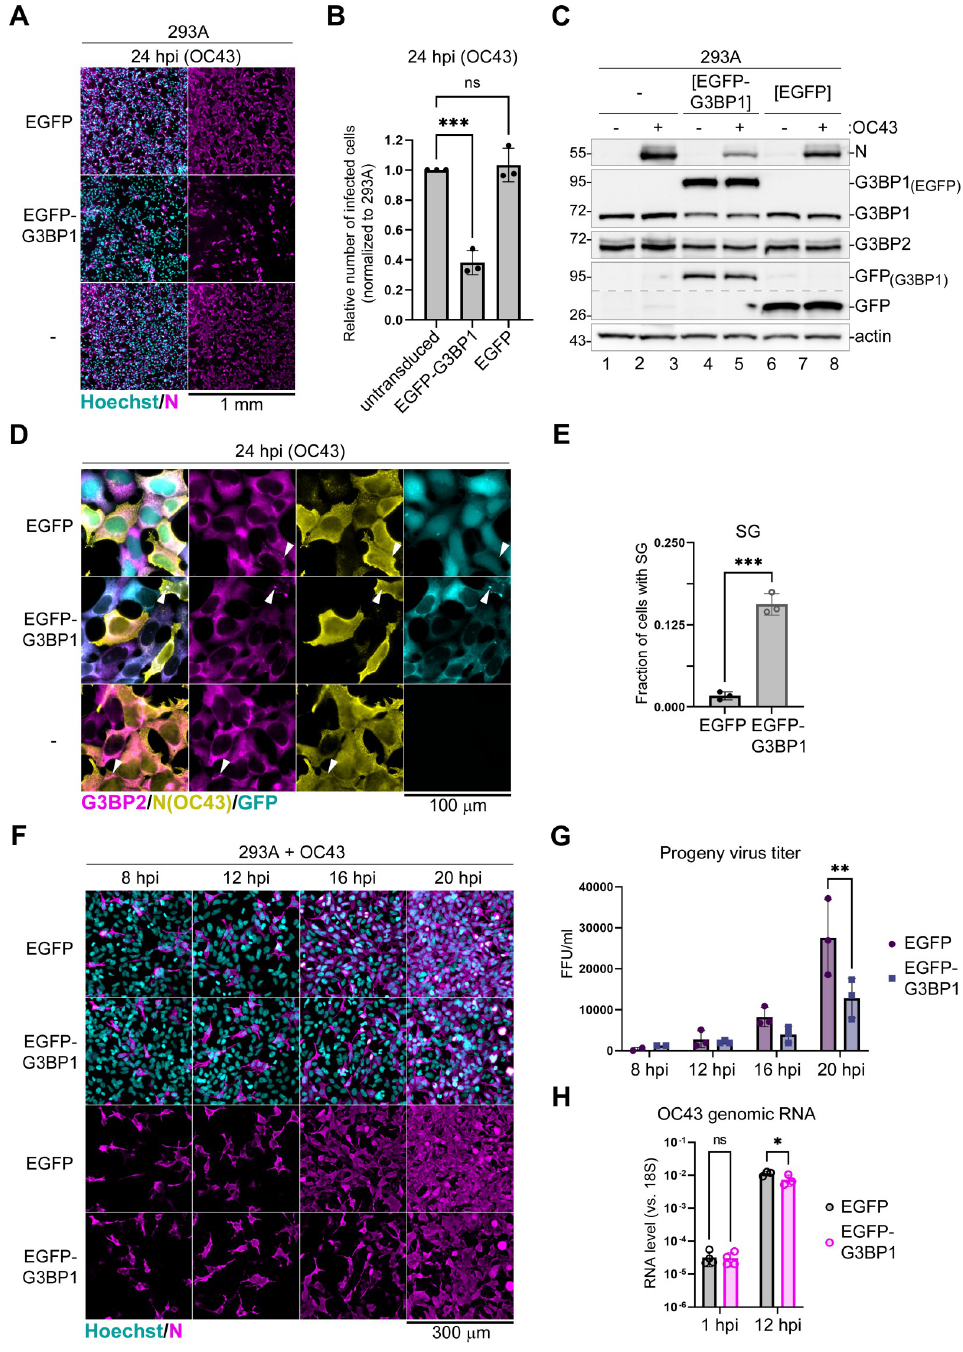
Fig 8. G3BP1 overexpression inhibits OC43 replication. (A) Immunofluorescence microscopy analysis of parental 293A cells (-), 293A[EGFP], and 293A[EGFP-G3BP1] cells infected with OC43 at MOI = 0.1 and stained for OC43 N protein (magenta) at 24 hpi. Nuclei were stained with Hoechst dye (teal). Scale bar = 1 mm. (B) Relative number of infected cells (normalized to 293A) in 293A[EGFP] and 293A[EGFP-G3BP1] cells at 24 hpi, quantified from A. (C) Western blot analysis of 293A, 293A[EGFP], and 293A[EGFP-G3BP1] cells infected with OC43 at 24 hpi. Anti-GFP blot was spliced along the dotted line to reduce vertical size. (D) Immunofluorescence microscopy of cells infected as in B and immunostained for G3BP2 (magenta) and OC43 N (yellow). GFP signal is shown in teal. Arrowheads indicate infected cells that formed SGs. Scale bar = 100 μ m. (E) Fraction of cells with SGs was quantified in OC43-infected 293A [EGFP-G3BP1] and 293A[EGFP] cells from D. (F) Immunofluorescence microscopy analysis of 293A[EGFP] and 293A